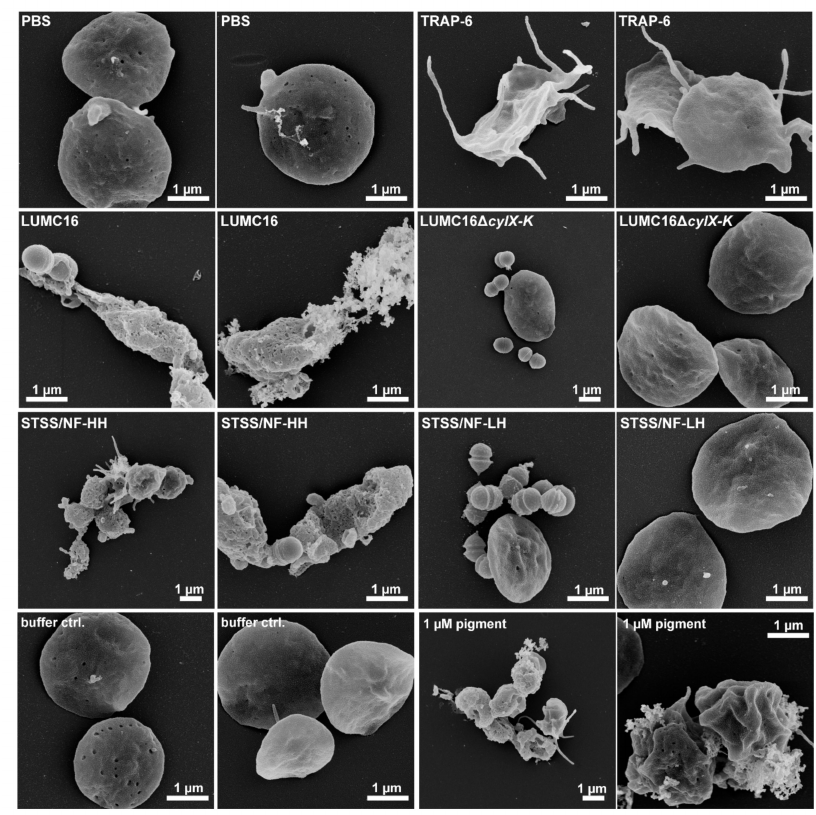
Figure 4. Platelet morphology in response to GBS infection or pigment stimulation. Washed human platelets were infected with indicated GBS strains or stimulated with pigment (1 µ M) for 120 min and were visualized via FESEM. PBS and TRAP-6 were used as negative and activation controls, respectively. Representative images from three independent experiments are shown ( n =